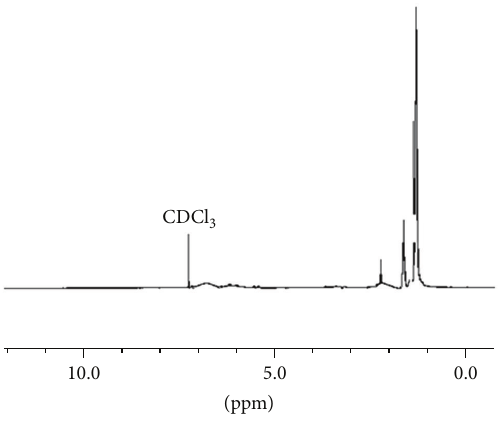
Figure 5: 1 H NMR spectra of poly-NTBA in CDCl 3 at 27 ∘